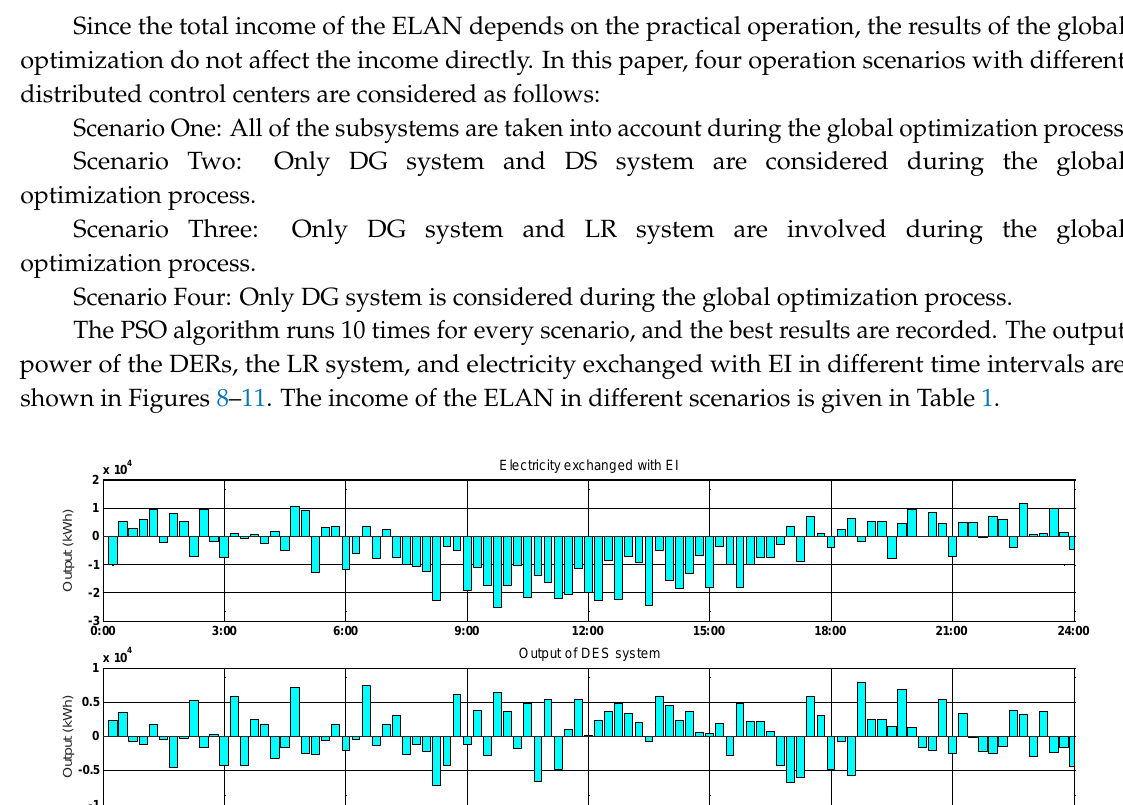
Figure 7. The forecast output curves of the DGs in the town.